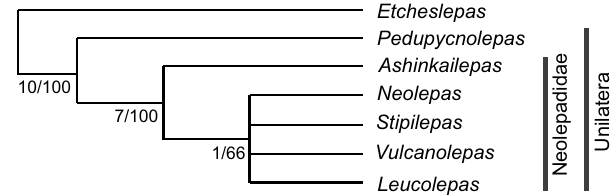
Fig. 7. Cladogram of relationships between Neolepadidae, Pedupycnolepas and Etcheslepas , using heuristic unconstrained analysis optimised to del- tran and based on characters listed in Table 1. Values are for Bremer sup-